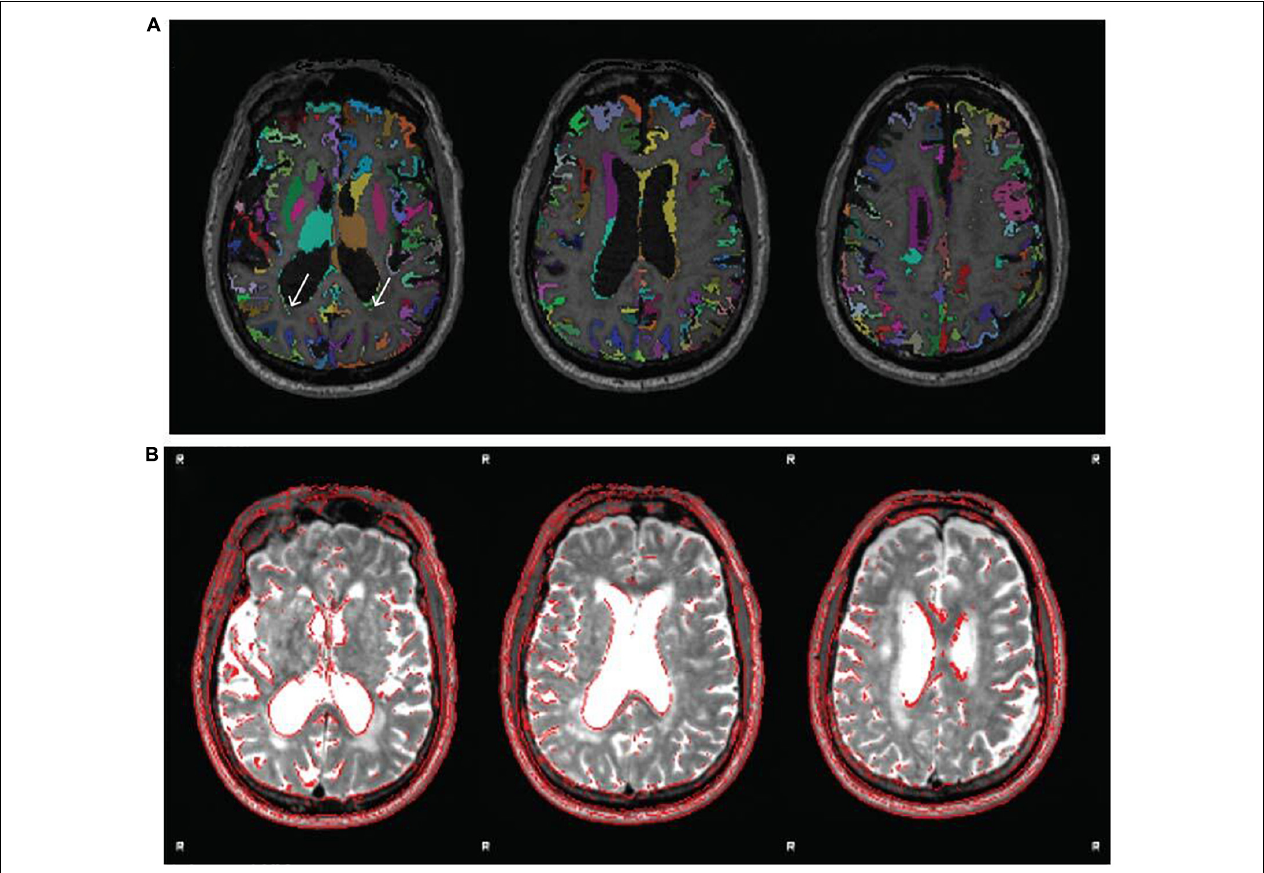
FIGURE 7 | Example of white matter lesion misclassification as gray matter. (A) The labeled gray matter image is shown on the T1w. (B) T2 ∗ image from the same older adult subject indicating a significant volume of white matter lesions that are also notable on the T1w. Although performing segmentation on the T1w image using age-specific tissue priors is largely successful despite the large white matter lesion volume, some misclassification remains [white arrows in panel (A) ]. Images reproduced from the example subject’s QC